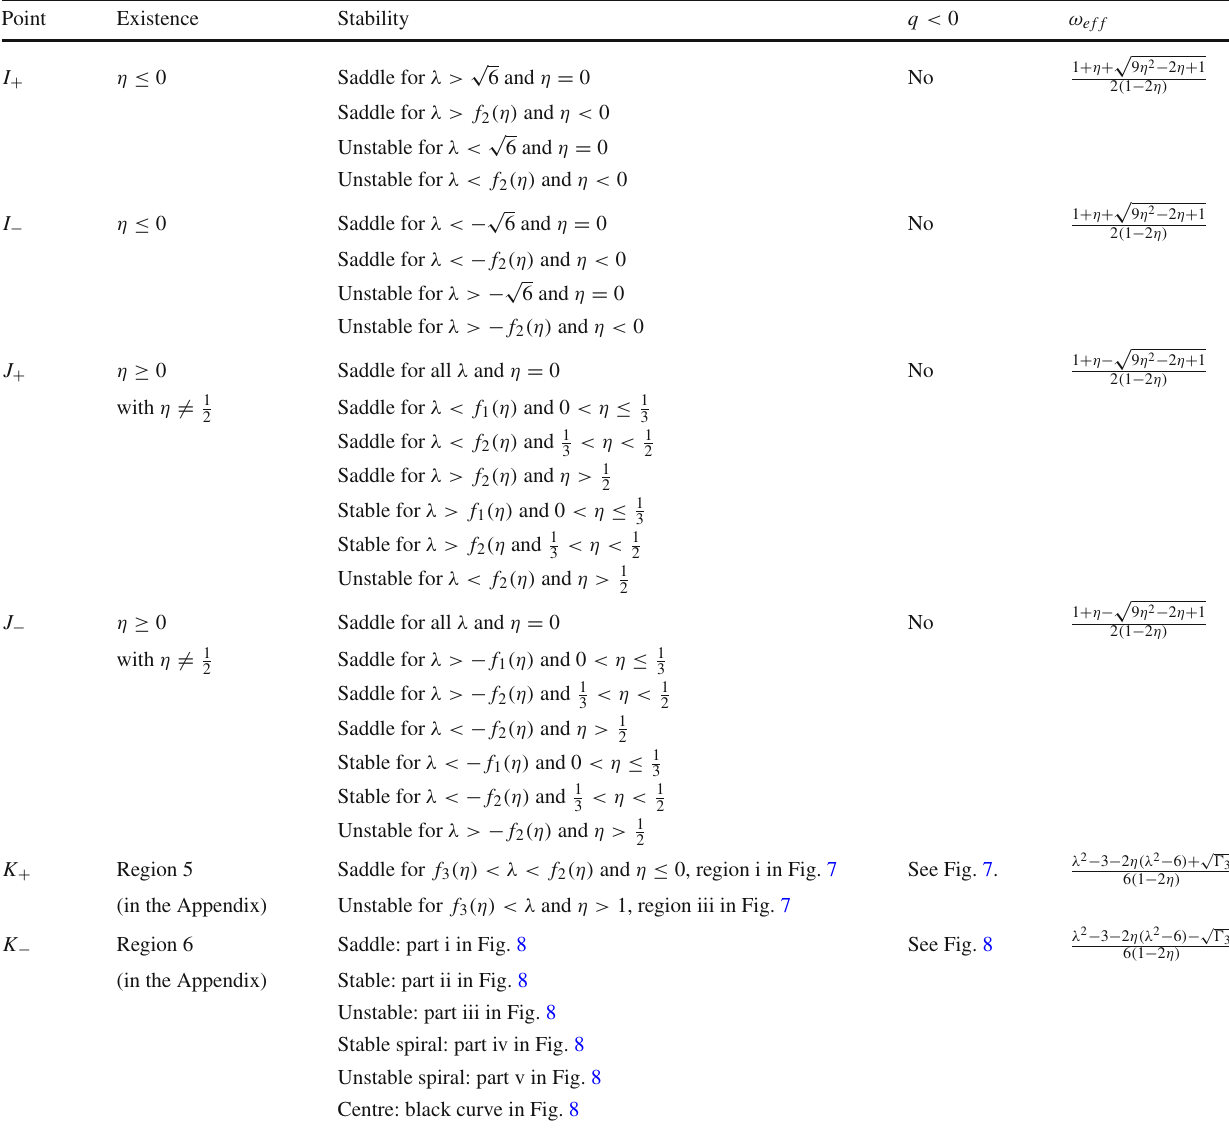
Table 7 The physically meaningful critical points of the autonomous system for the case α = − β ≡ η Point